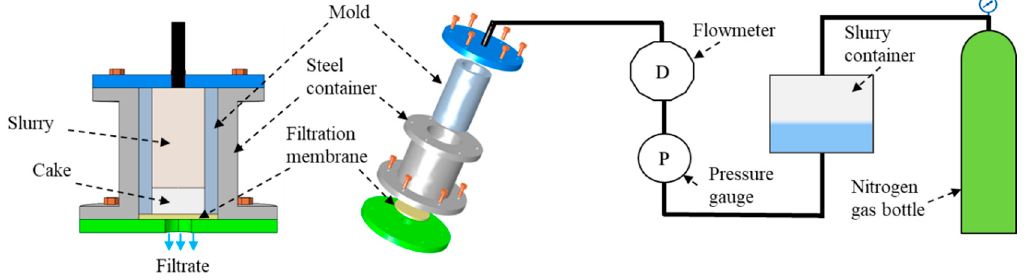
Figure 1. Scheme of the pressure slip-casting apparatus.